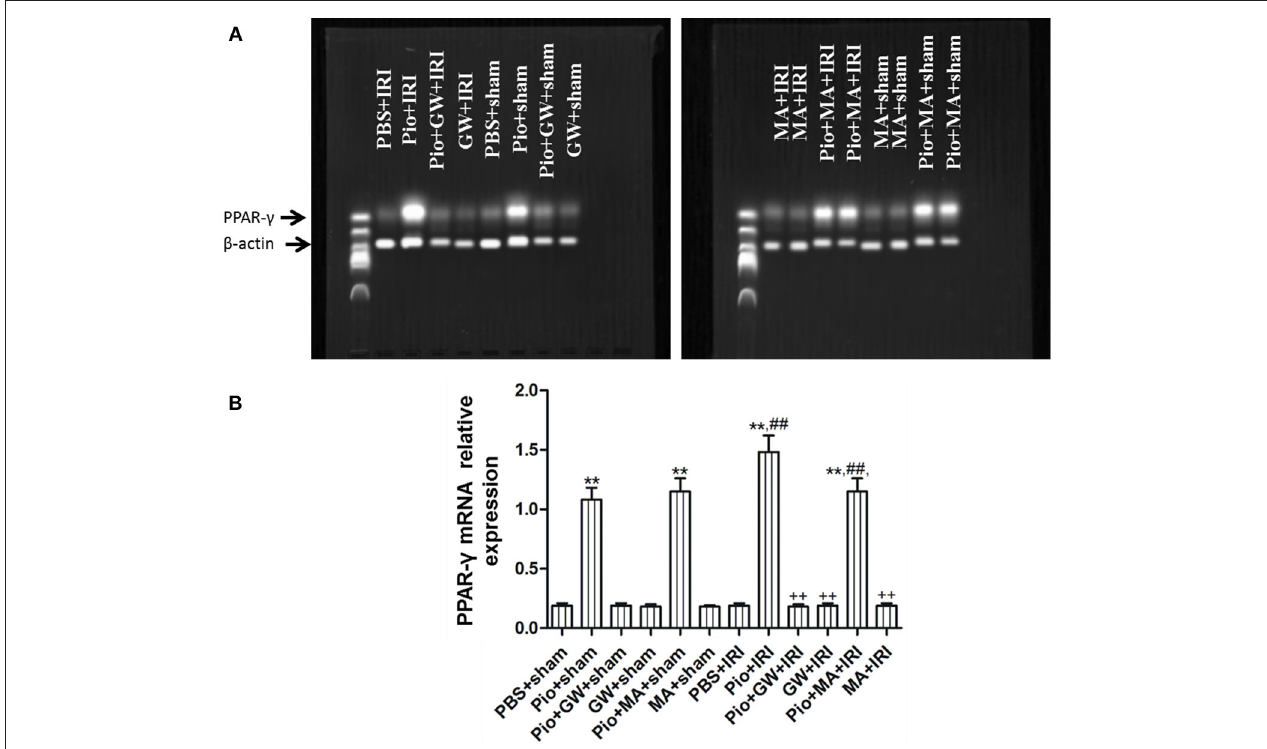
FIGURE 5 | Pioglitazone up-regulates PPAR- γ mRNA. (A) Representative bands show PPAR- γ mRNA in the kidneys at 24h after renal IRI. (B) Quantitative analysis of PPAR- γ mRNA in the kidneys at 24h after renal IRI. Compared with the PBS + sham group, **represents for P < 0.01; Compared with the PBS + IRI group, ## represents for P < 0.01; Compared with the Pio + IRI group, ++ represents for P < 0.01. n = 6 in each group. PPAR- γ , peroxisome proliferators-activated receptor- γ .